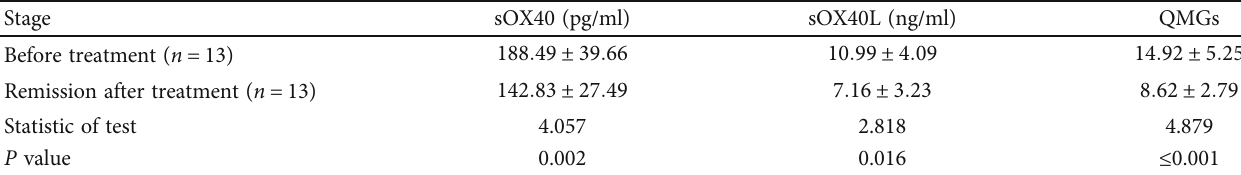
Figure 2: OX40/OX40L expression on the peripheral blood lymphocytes and plasma in di ff erent stages of MG patients. (a) Representative expression of OX40 and OX40L on CD4 + T cells, CD19 + B cells, and CD14 + mononuclear cells in MG patients at baseline, in relapse and in remission. The red lines indicate speci fi c staining results measured by fl ow cytometry, and the blue lines indicate isotype controls. (b) Comparison of OX40 expression on CD4 + T cells in MG patients at baseline, in remission, and in relapse. (c) Comparison of OX40L expression on CD19 + B cells in MG patients at baseline, in remission, and in relapse. (d) Comparison of OX40L expression on CD14 + mononuclear cells in MG patients at baseline, in remission, and in relapse. (e) Comparison of sOX40 plasma levels in MG patients at baseline, in remission, and in relapse. (f) Comparison of sOX40L plasma levels in MG patients at baseline, in remission, and in relapse. Table 4: Comparison of sOX40 and sOX40L expression in the plasma of patients with relapsing MG before and after immunosuppressive